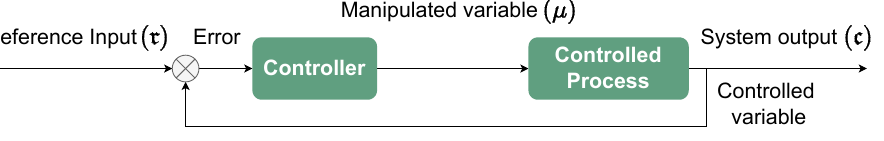
Figure 3. Closed-loop control system for congestion